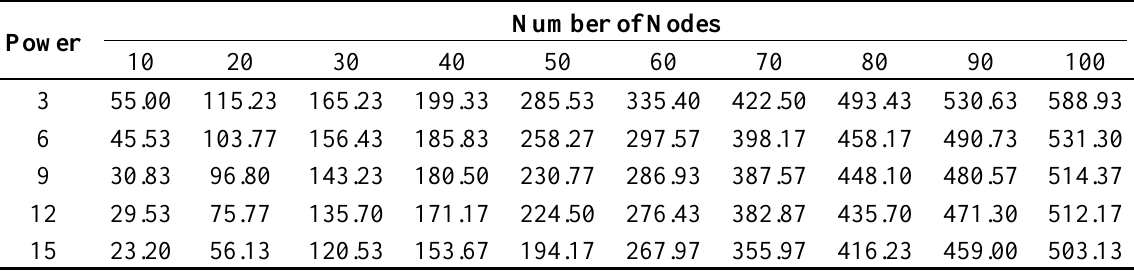
Table 9. Scheduling time in the general topology.